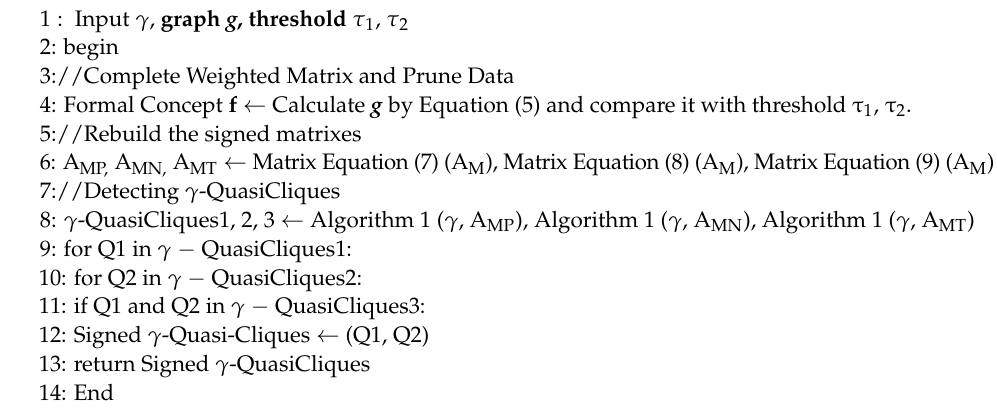
Algorithm 2 The overall flow of community detection algorithms